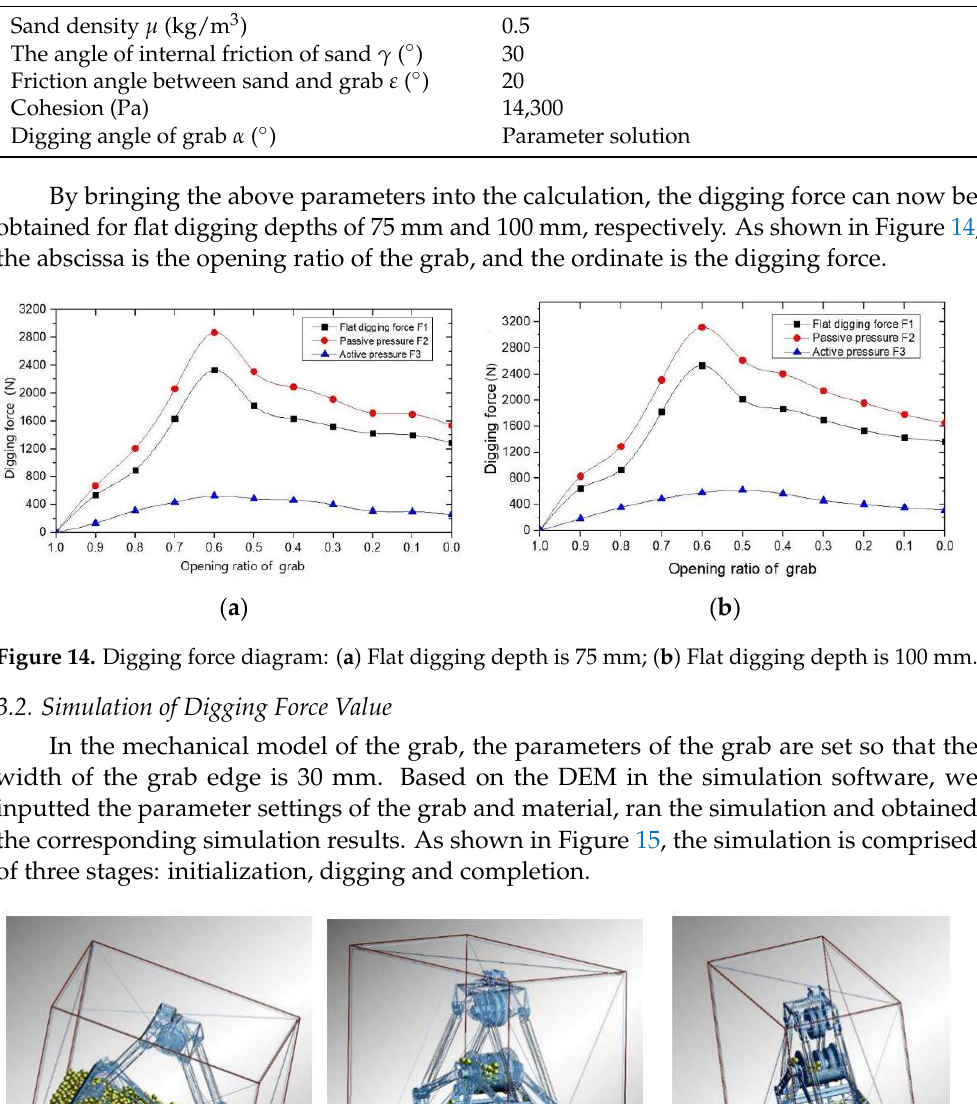
Table 2. Main characteristic parameters.